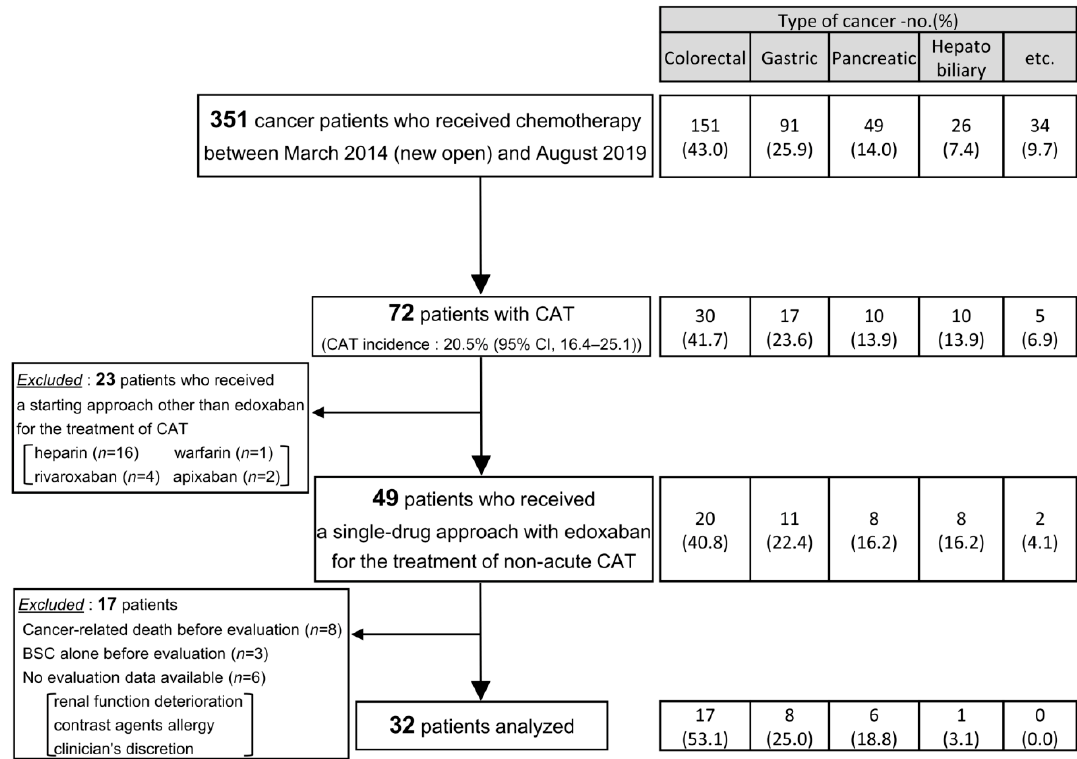
Figure 1. Flowchart and table indicating the number of patients included in and excluded from this analysis.